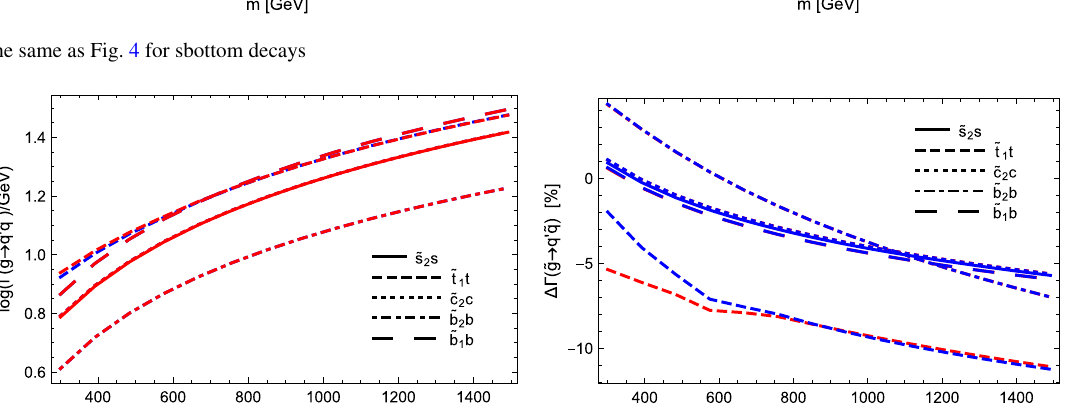
Fig. 5 The same as Fig. 4 for sbottom decays